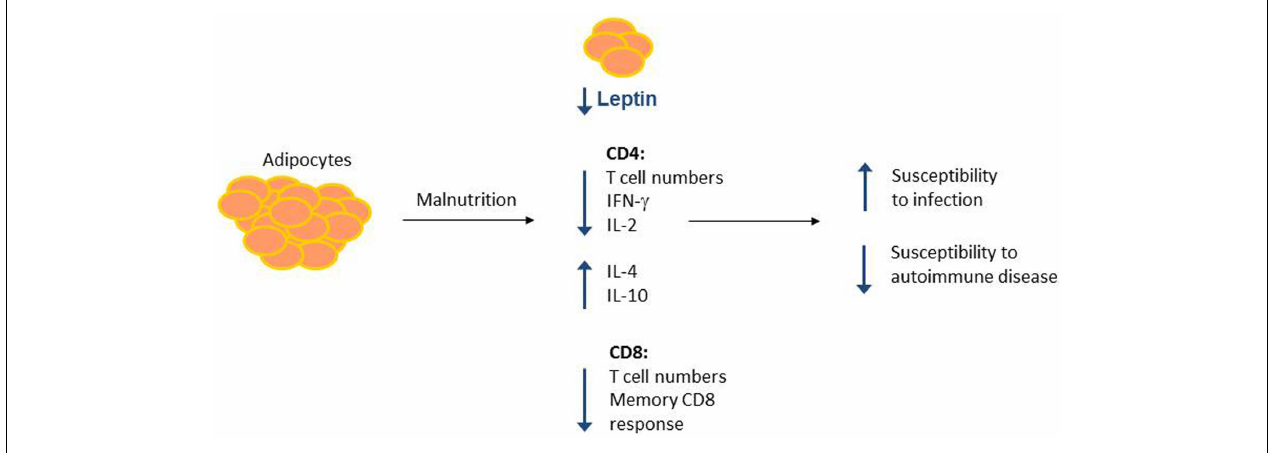
and function, leading to increased susceptibility to infection and protection against certain forms of autoimmunity. Leptin may mediate a subset of these malnutrition-related changes toT cell number and function, as leptin is known to alter CD4 + T cell number and cytokine